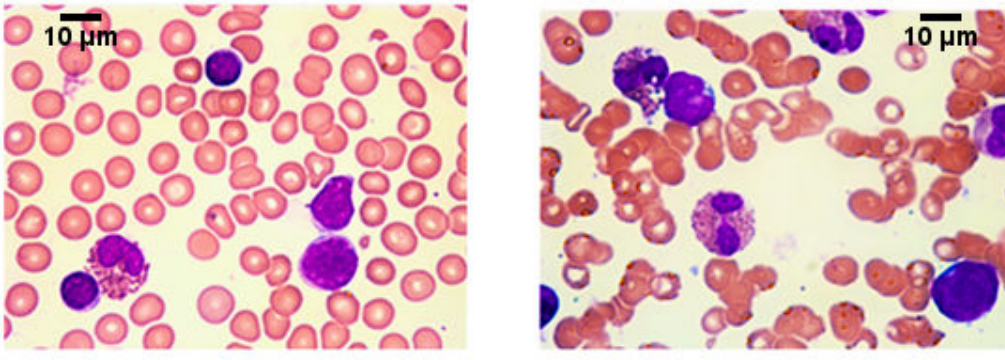
Figure 1. Bone marrow smear showing an infiltration of blasts typical of B-cell ALL equal to 20–30% with associated